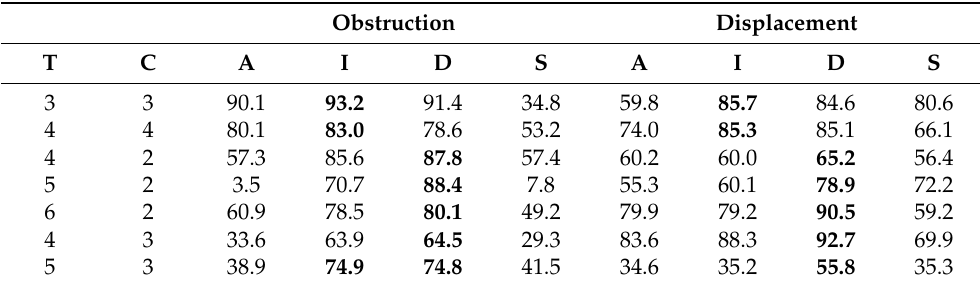
Figure 4. From top to bottom: Plots of accuracy vs. number of iterations for the obstruction, displacement, rotation, and re-scaling tasks. The mean over 50 trials is drawn with the shaded region, representing ± 2 σ calculated empirically. The source domain included five random classes from the source domain, which were different for each trial. The red-shaded region illustrates the mean accuracy for the experiment where no target outliers were present. The blue-shaded region illustrates the mean accuracy when five outlier labels were added to the target domain. The figure is best viewed in color. Table 1. The results of Experiment 2 for the obstruction and displacement cases. “T” is the number of target labels and “C” is the number of target labels common to the source. “A” is the performance of ADDA [9], “I” is the performance of IWPDA [8], “D” is the performance of DIWAN, and “S” is the performance of the source model without adaptations. The results are the average accuracy percentages over 10 trials. Best accuracy indicated in